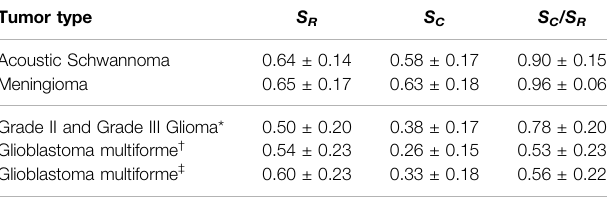
TABLE 3 | Regularity measures results for different brain tumor types.